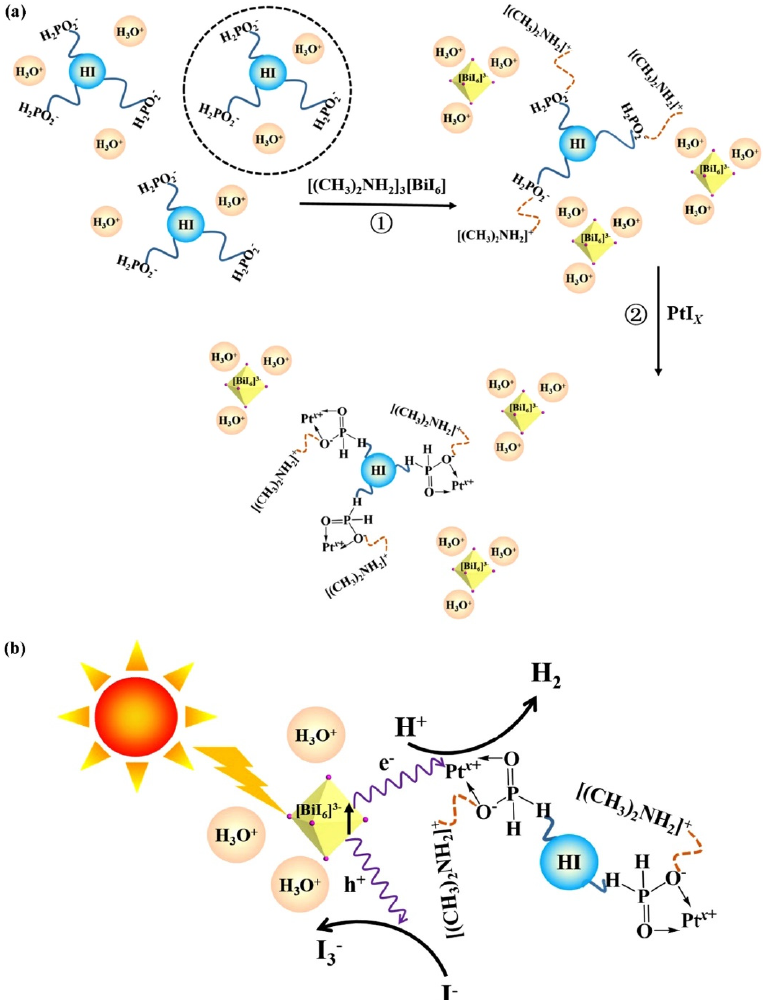
Figure 4. Schematic illustration of ( a ) the conversion process in the colloidal solution and ( b ) the proposed mechanism for photocatalytic hydrogen generation